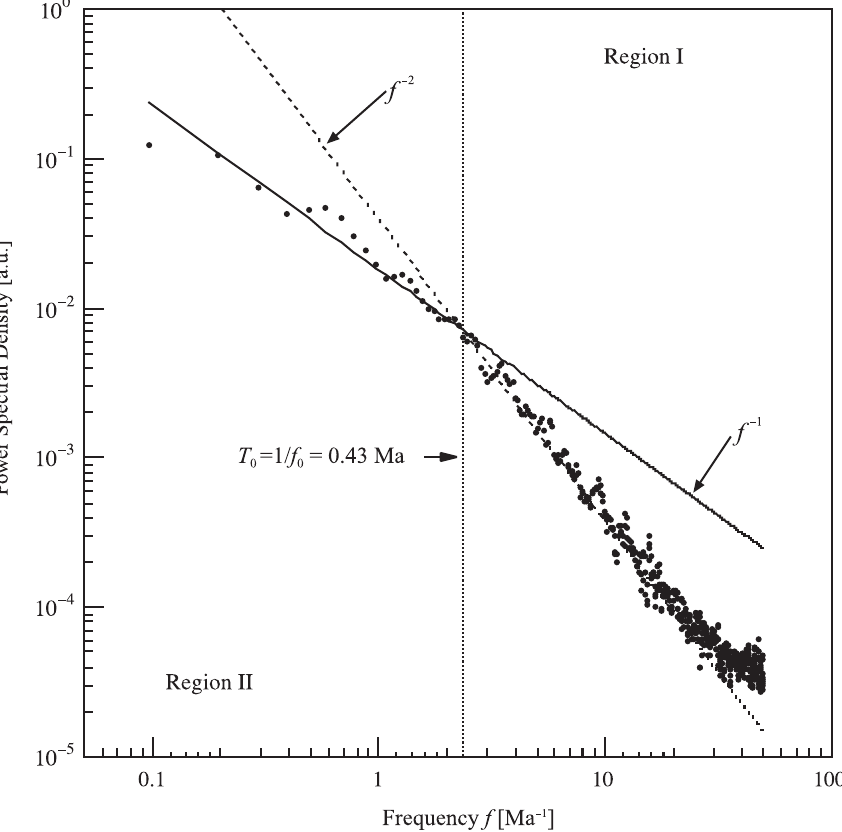
Fig. 2. The PSD, in arbitrary units (a.u.), of the surrogate polarity time series. The solid and dashed lines are nonlinear power-law best fi ts. The dotted vertical line indicates the position of the spectral